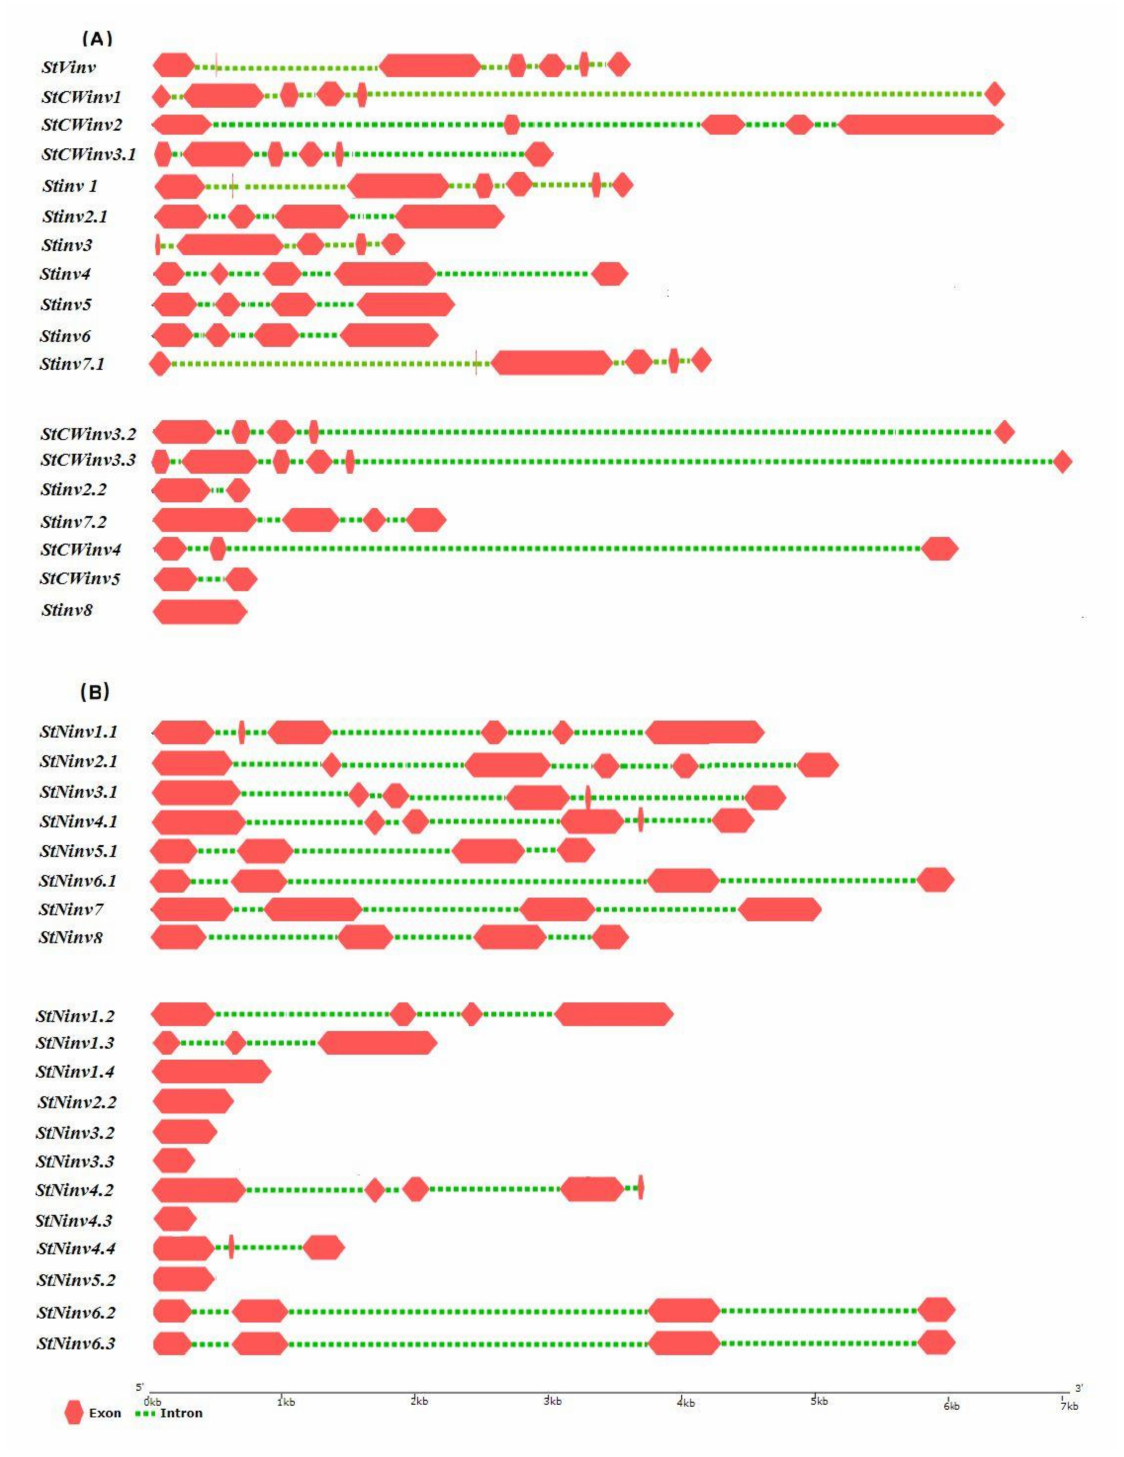
Figure 4. Symbolic structural representation of invertase gene family in Solanum tuberosum . Pink boxes represent exons and green dotted lines represent introns. ( A ) Acidic invertase sub-family. ( B ) Neutral/alkaline invertase